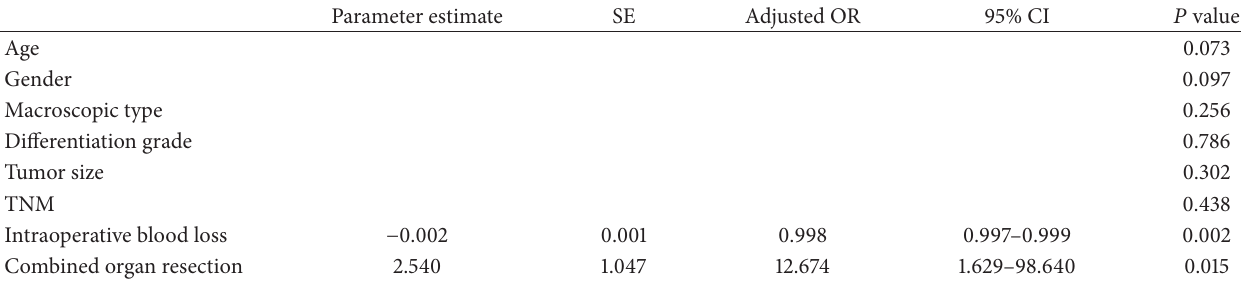
Table 3: Multivariate analysis of risk factors for blood transfusion in patients with POHb between 70 and 100 g/L.